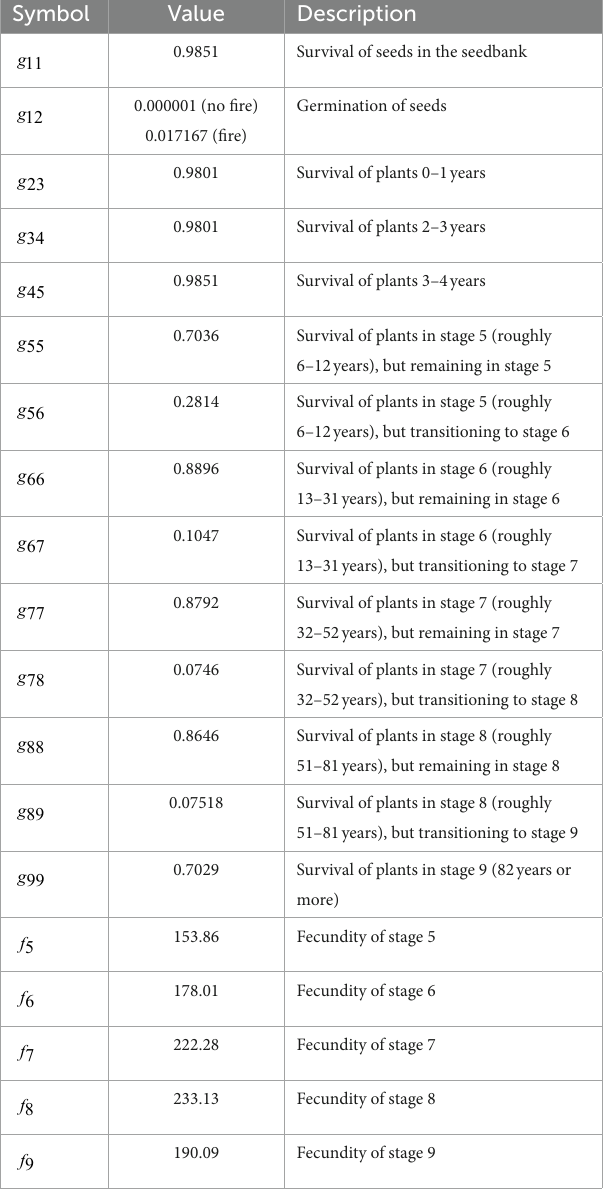
TABLE 1 Values for 2-year transition matrix of Ceanothus perplexans populations used in the spatially explicit demographic